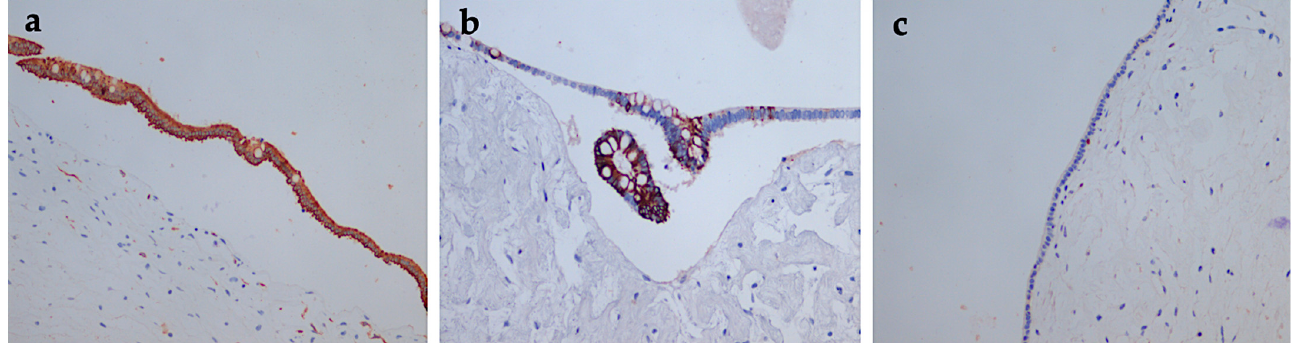
Figure 5. Immunohistochemical findings of the pancreatic hamartoma. ( a ) CK8/18 diffuse positive in the cysts epithelium, 200×; ( b ) CK20 focal positive in epithelial cells, 200×; ( c ) Low proliferative index—Ki67 (<1%) in the hamartomata’s epithelium, 200×.